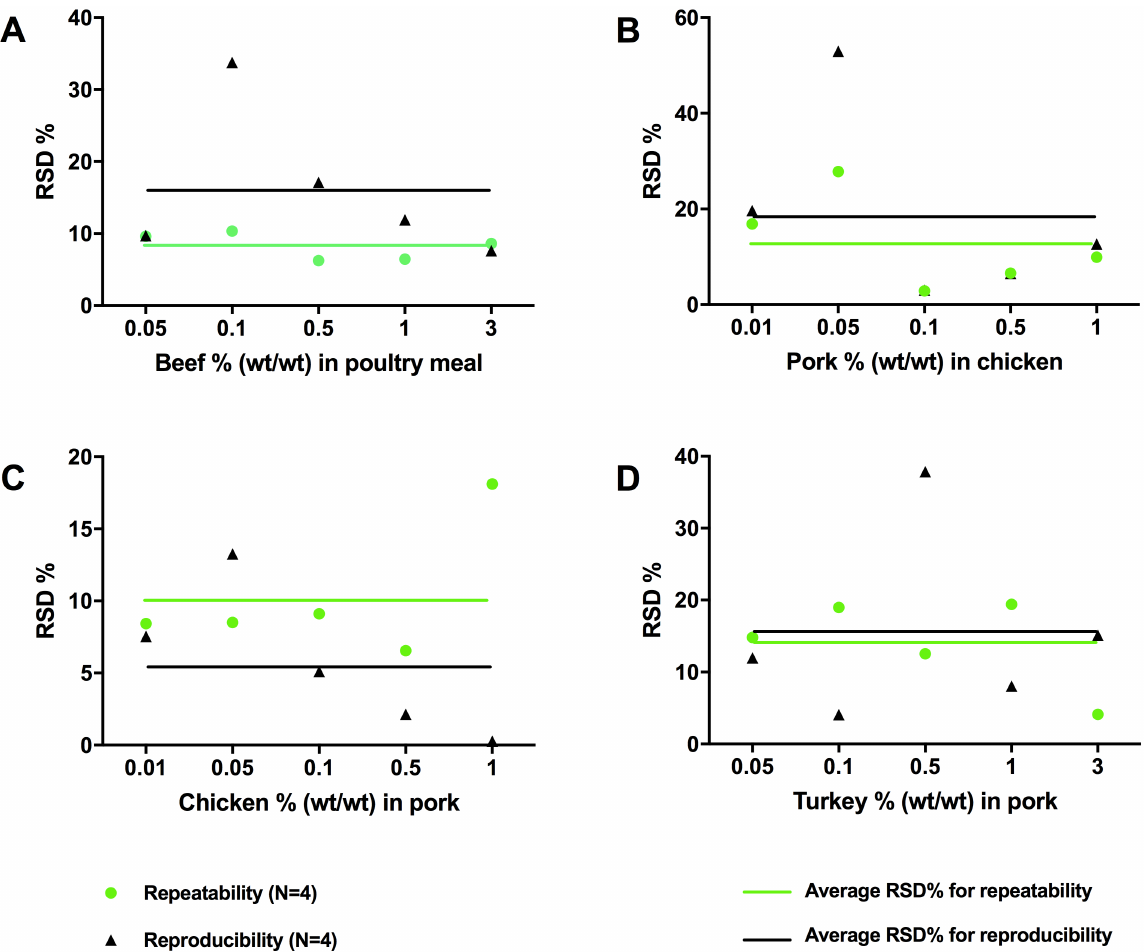
Fig 3. Repeatability and reproducibility of the ddPCR methods. Relativestandarddeviations(RSD%) are presented for fortified heat-processed (A) beef in poultry meal, (B) pork in chicken, (C) chicken in pork and (D) turkey in pork. Lines represent averageRSD % for repeatabilitybetweenDNA extractions and reproducibility betweendifferent operators. The data points cover all five spiking levels as labeledfor each of the target species